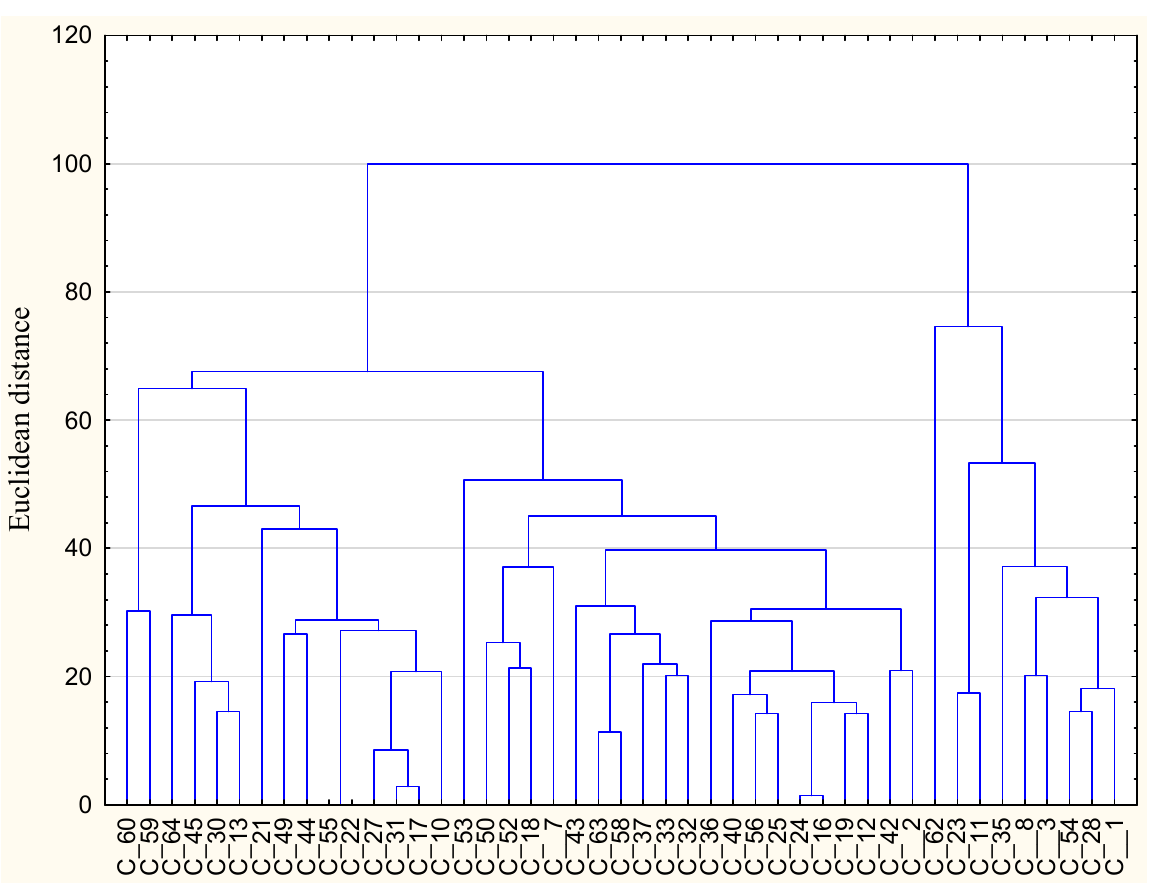
Figure 3. Hierarchical classification of the F1 progeny regarding LB resistance, genotypes number: C_1-925-15,